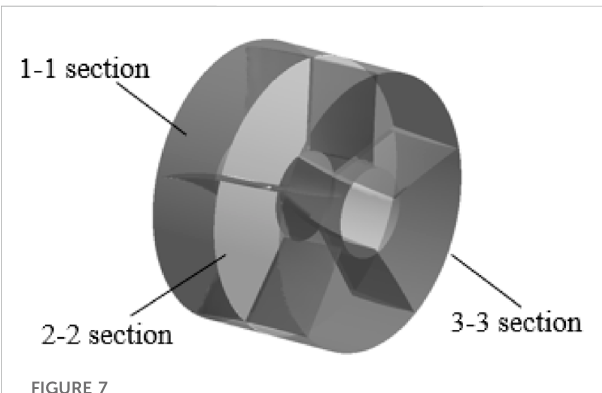
Characteristic section diagram of guide